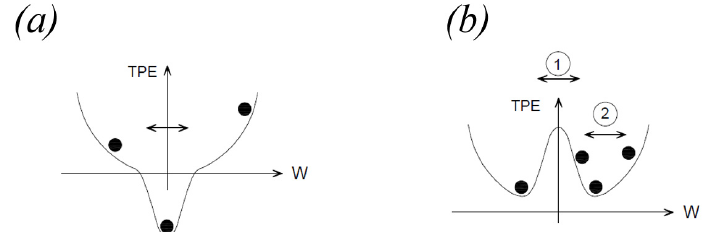
Figure 3. Qualitative total potential energy (TPE) function with respect to tip displacement W, for two versions of the system in Equation (1): ( a ) attractive configuration; ( b ) repulsive configuration with inter-well (1) and intra-well (2) mechanisms.